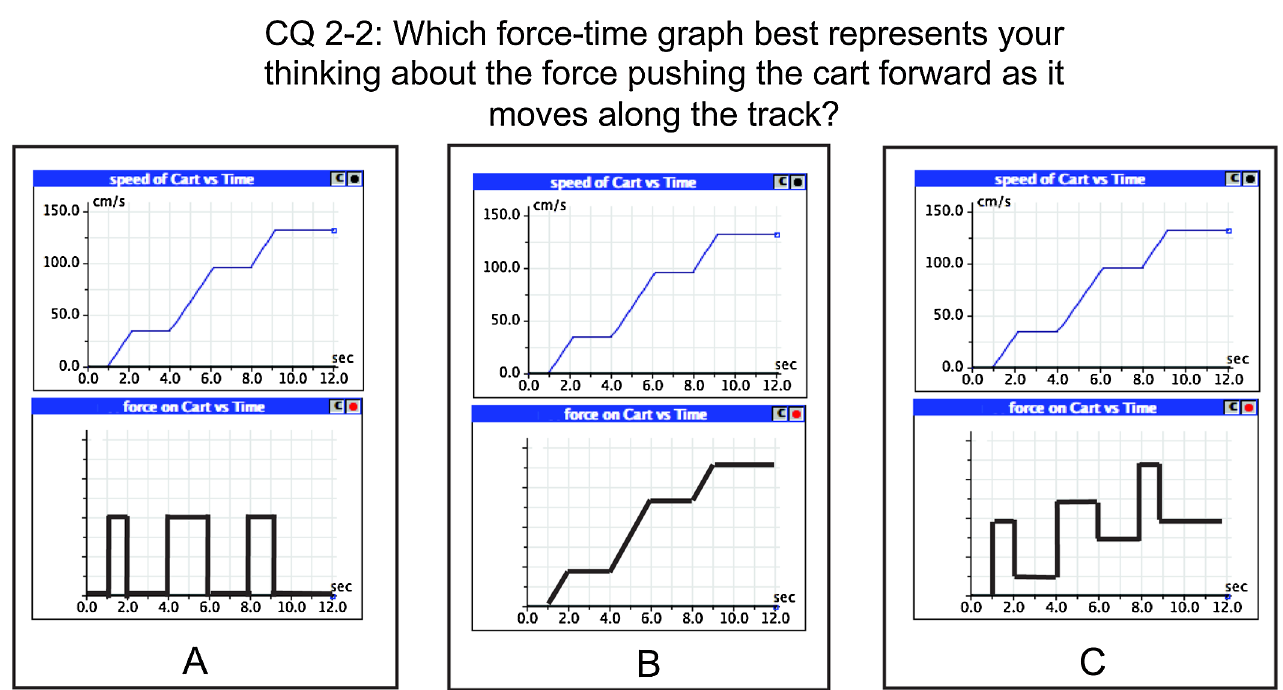
FIG. 10 (color online). The second clicker question in